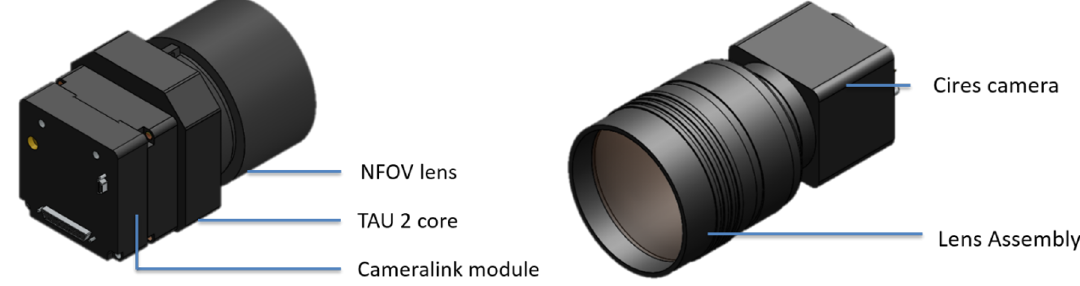
Figure 4. Thermal camera ( left ) and visible camera ( right )